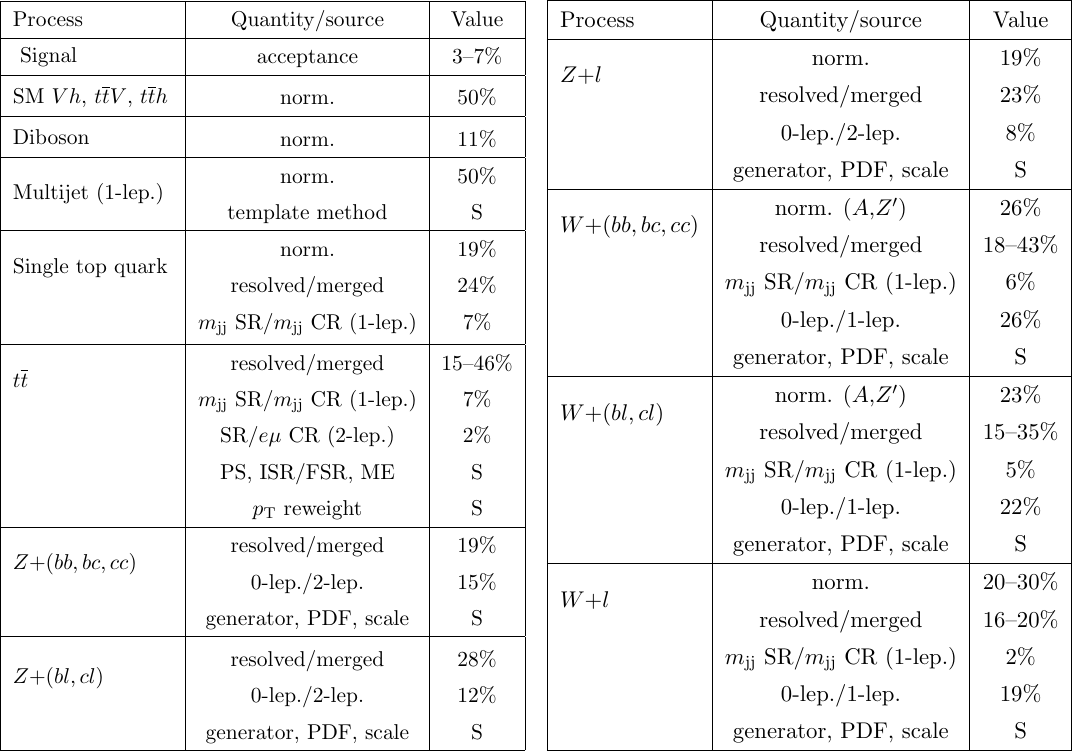
Table 3. Relative systematic uncertainties in the normalisation, cross-region extrapolation, and shape of the signal and background processes included in the (cid:12)ts described in the text. An \S" indicates a shape variation is included for the sources listed, \/" indicates a ratio of two regions, and \norm." is the sum of cross-section and acceptance variations. A range of values means the value depends on the lepton channel. Parentheses indicate when the uncertainty applies only to a given (cid:12)t or a given